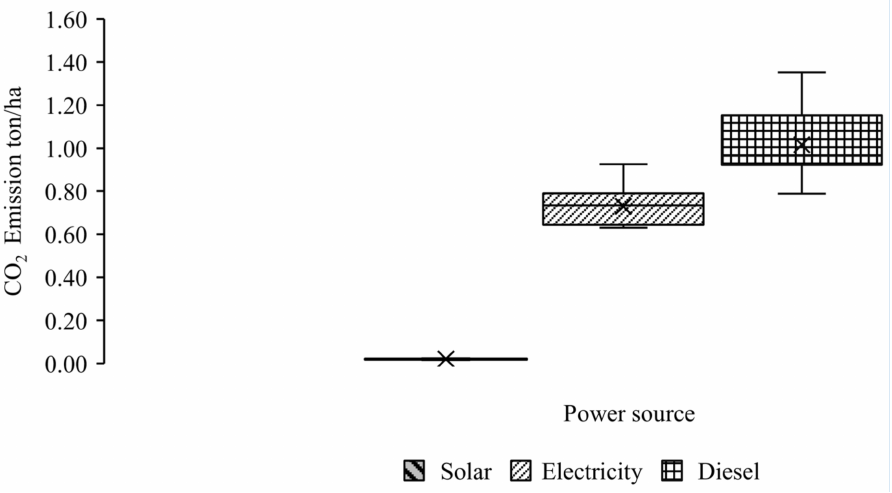
Figure 11. CO 2 emissions from different power sources for DIS. From all the calculations and analysis, it was also calculated that diesel power DIS the diesel engine runs for 60.6 h to irrigate the maize crop and consumes about 323.40 L of diesel and emits 1.02 tons of CO 2 /ha into the air, whereas electric power DIS runs for 56.13 h and consumes 1008.27 KW of electricity and emits 0.73 tons of CO 2 /ha into the atmosphere, and solar power DIS consumes 1190.14 KW of electricity produced by solar and emits 0.02 tons of CO 2 during the life of the maize crop on ha area. CO 2 Emission Form Each Source for 1 kg Production of Maize Solar power DIS emits the least carbon dioxide, which is almost 0.0016 kg for the production of 1 kg of maize, whereas diesel power DIS emits 0.0848 kg, which is much higher than electricity and solar emits 0.0599 kg and 0.0016 kg, respectively, as presented in Figure 12.